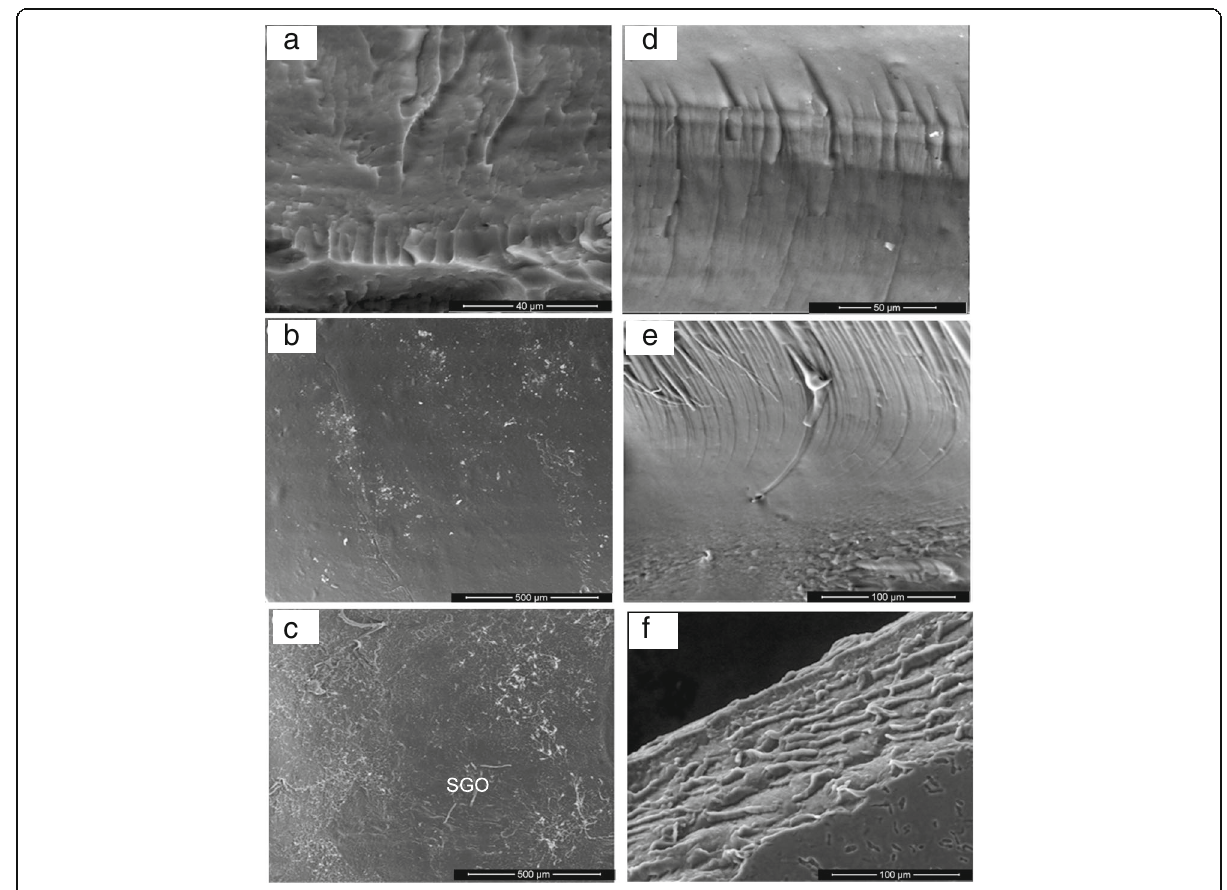
Fig. 4 FESEM images of surface morphology and cross-section for a , d sodium alginate, b , e SA/SGO4, and c , f SA/SGO6 biomembranes